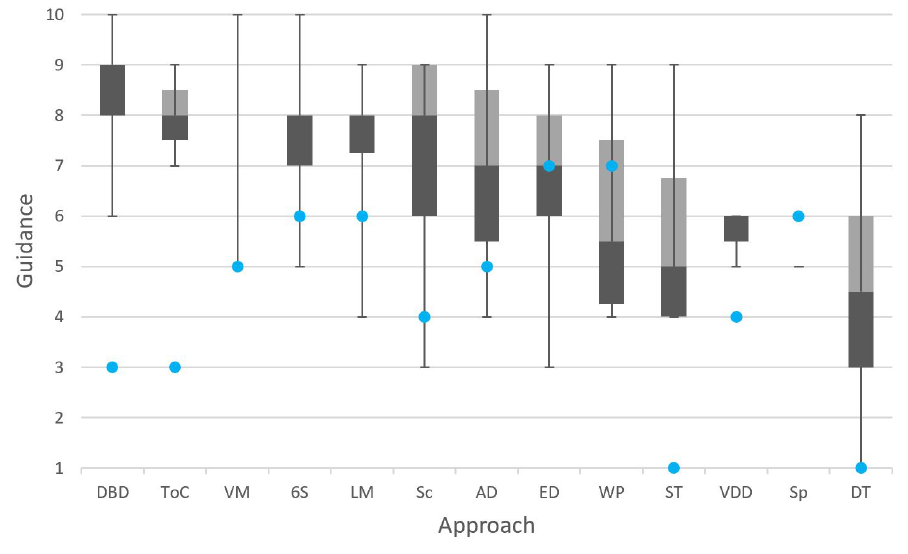
Figure 6. Level of guidance each approach provides. Shaded boxes span the interquartile range, separated by the median. Error bars represent upper and lower extremes. Blue dots represent the authors’ initial classification. Approaches ordered by decreasing mean, with ties broken by increasing standard